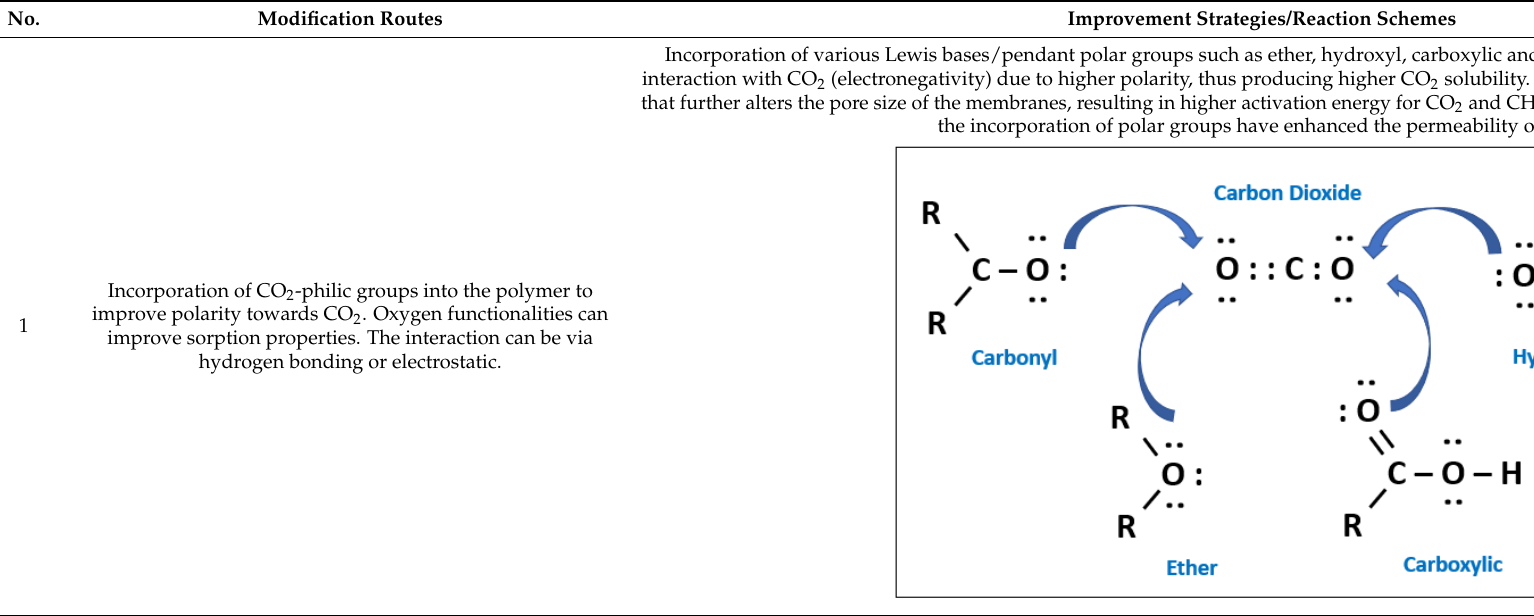
Table 4. Summary of polymer-modification improvement strategies.